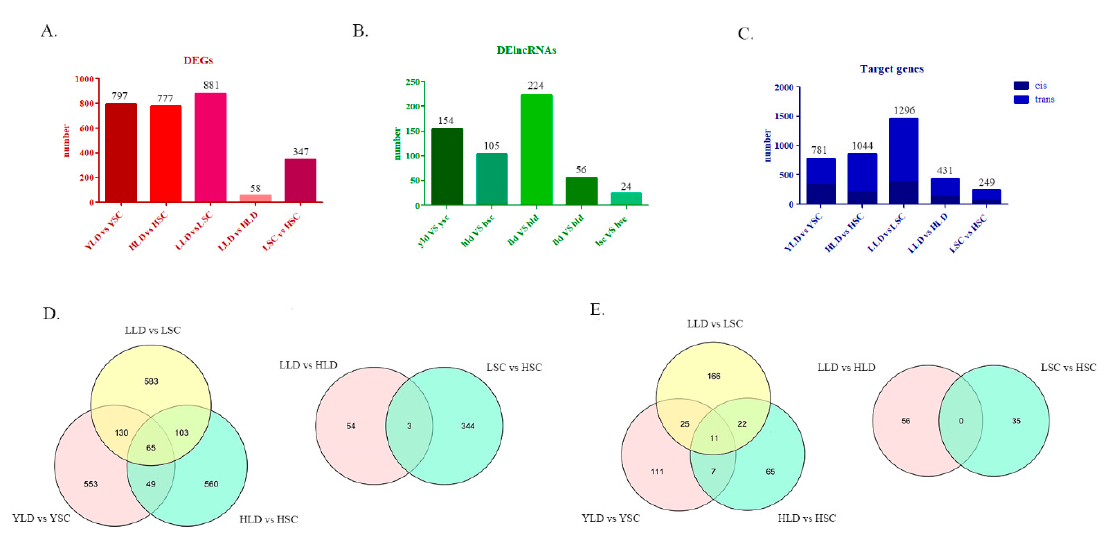
Figure 2. Histogram of the number of DEGs ( A ), DE lncRNAs ( B ), and target genes ( C ) in the different groups. Venn diagram of the DEGs ( D ) and the DE lncRNAs ( E ) in the different groups.